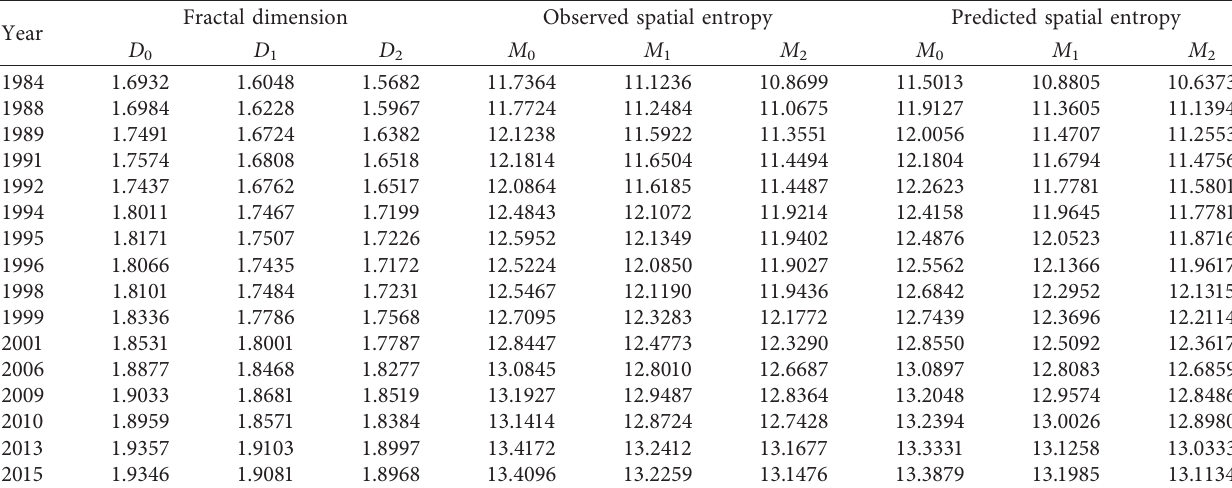
Table 3: Spatial entropy values and corresponding fractal dimension of urban form of Beijing